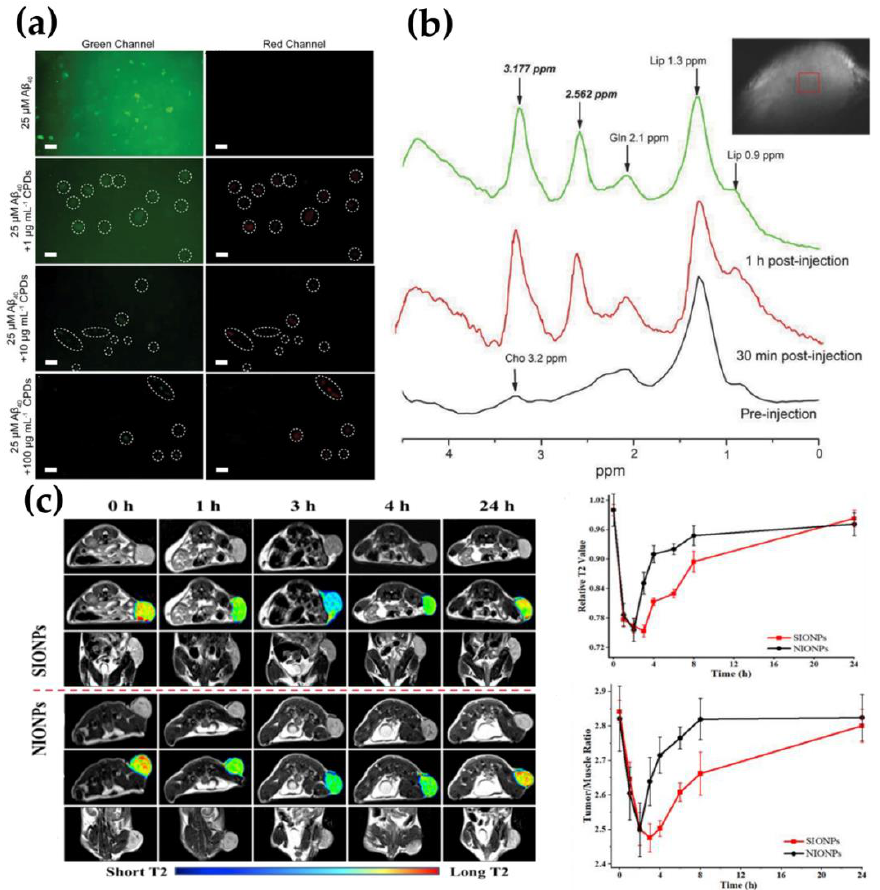
Figure 2. ( a ) FL of Aβ40 incubated with or without CPDs after 56 h at 37 °C, reprinted from [84]. Copyright 2020, with permission from Weily; ( b ) MRS spectra of subcutaneously transplanted gli- oma before and after the intratumoral injection of 1 mL AMSNs physiological saline solution (10 mg AMSNs/mL, 40 mg AMSNs/kg), reprinted from [77]. Copyright 2018, with permission from Weily; ( c ) in vivo T2-weighted imaging and the corresponding time course of relative T2 signal intensity of tumors, reprinted from [79]. Copyright 2021, with permission from Elsevier.